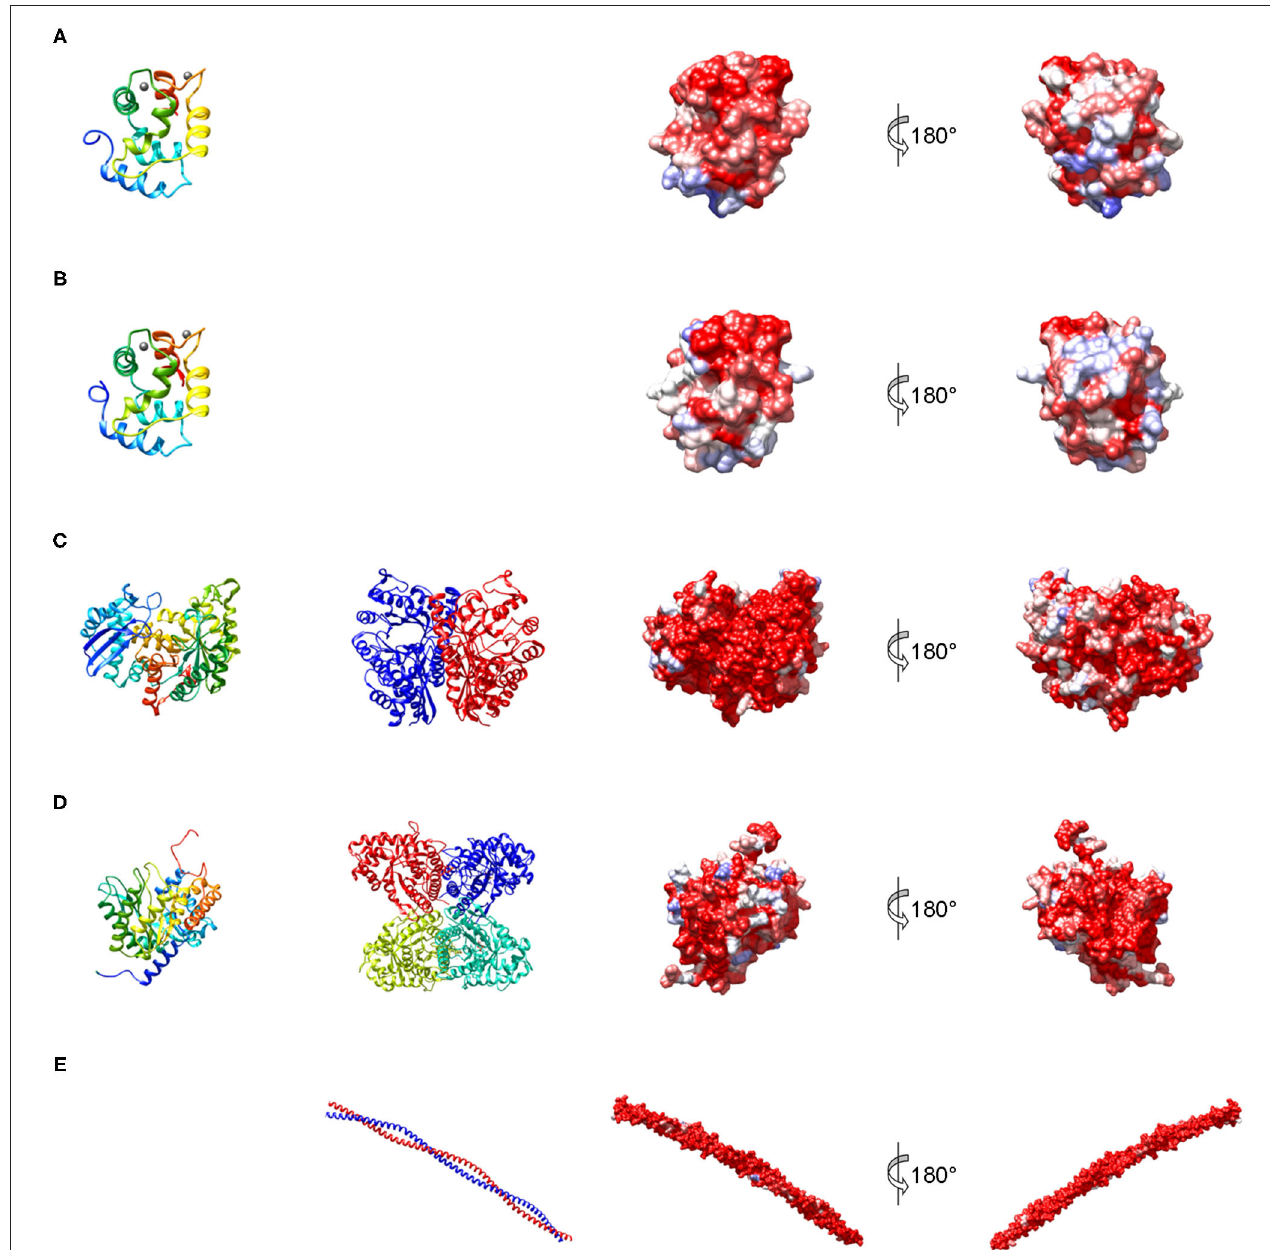
FIGURE 3 | Structures representing the most important families of fish allergens. (A) β -Parvalbumin from common carp (PDB: 4cpv); (B) α -parvalbumin from Northern pike (PDB: 1pva); (C) human β -enolase (PDB: 2xsx); (D) aldolase A from rabbit (PDB: 1ado); (E) human tropomyosin α 1 (PDB: 6x5z). Left column: secondary structure of a single subunit colored from blue (N-terminus) to red (C-terminus); middle column: quaternary structure; right columns: molecular surface colored by sequence conservation derived from a sequence alignment of vertebrate homologs from blue (different residues in all sequences) to red (identical residue in all